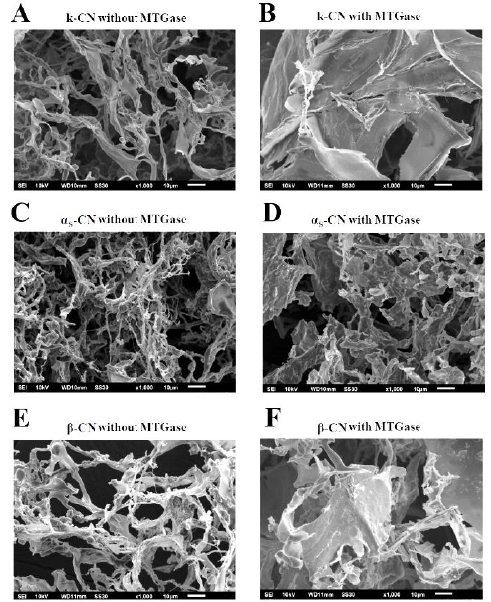
Figure 7. SEM images of casein proteins (2 mg) without/with 2.0 units/mL MTGase at 30 °C for 3 h. ( A ) κ -CN without MTGase; ( B ) κ -CN with MTGase; ( C ) α S -CN without MTGase; ( D ) α S -CN with MTGase; ( E ) β -CN without MTGase; and ( F ) β -CN with MTGase.